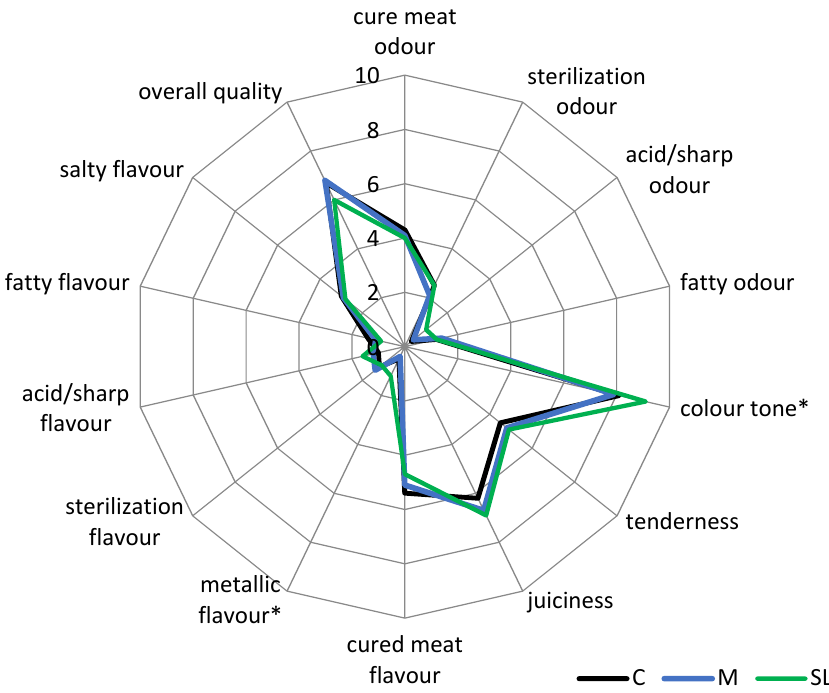
Figure 3. Sensory profile of experimental treatments after eight weeks of storage. C—control treatment with NaNO 2 in an amount of 100 mg/kg; M—treatment with NaNO 2 in an amount of 50 mg/kg; SL—treatment with NaNO 2 in an amount of 50 mg/kg and L. fermentum S8 at about 10 7 cfu/g and S. carnosus ATCC 51,365 at about 10 7 cfu/g; * Mean values of these attributes differ significantly ( p < 0.05).